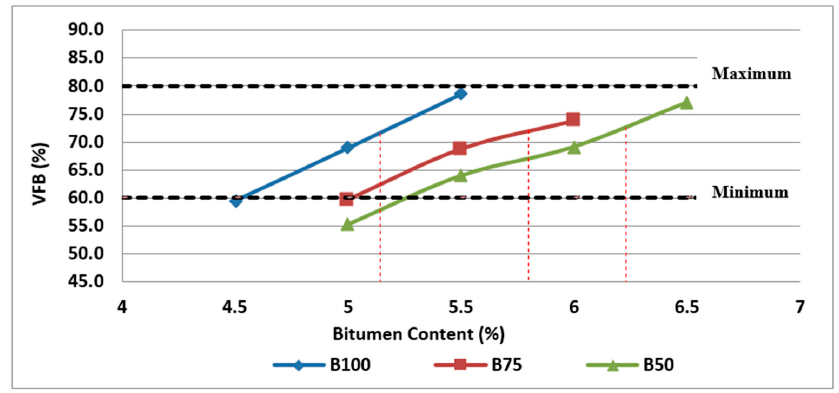
Figure 8. Effect of bitumen content and RCA content on VFB of Mix I containing virgin aggregate and Mix II and Mix III containing RCA as coarse aggregate.